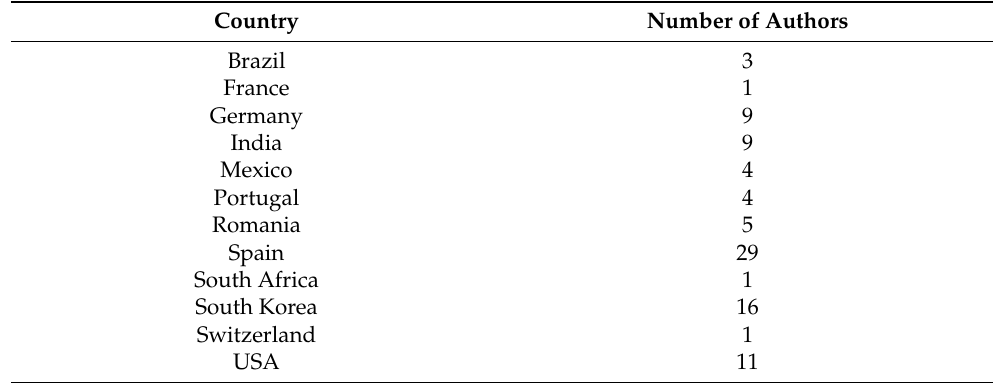
Table 1. Authors’ affiliations by country (geographical